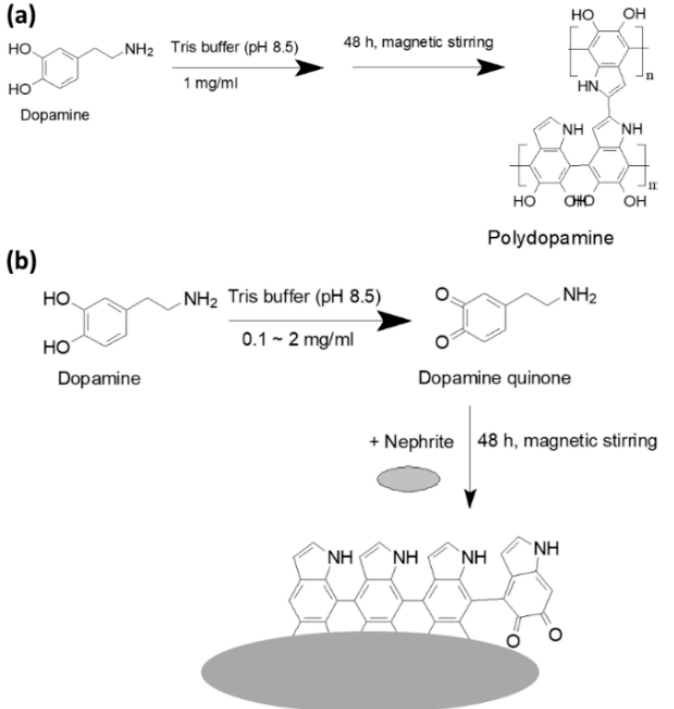
Figure 1. PDA copolymer synthesized by the polymerization of dopamine in the aqueous solution ( a ). PDA-coated nephrite composites by the polymerization of dopamine ( b ). PDA-coated nephrite composites: Dopamine (1 g) was dissolved in 100 mL Tris buffer (10 mM, pH 8.5) and then 1 g of nephrite powder was added. This solution was